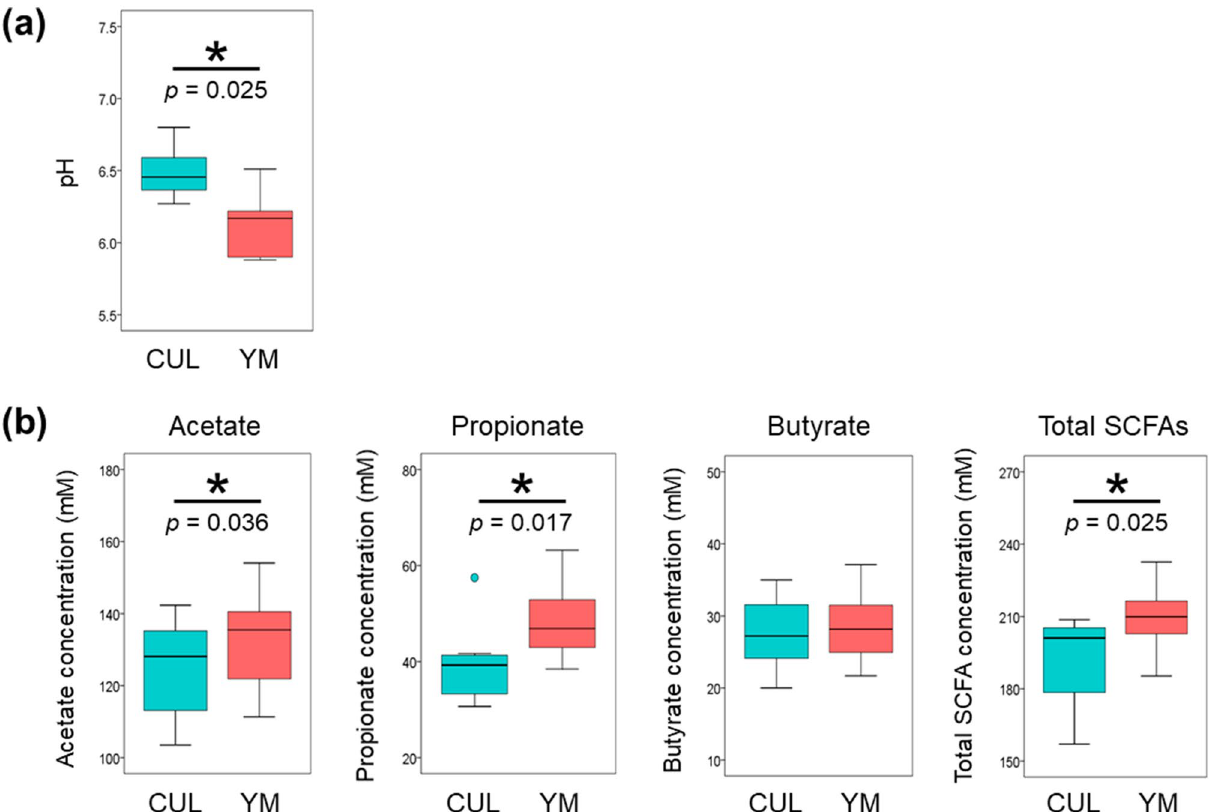
Figure 5. Changes in pH ( a ) and production of short-chain fatty acids (SCFAs) ( b ): acetate, propionate, butyrate, and total SCFAs after 30 h of fermentation in the KUHIMM without yeast mannan (CUL) and with the 0.4% yeast mannan preparation (YM). Asterisks (*) represent significant differences (* p < 0.05) (n = 8) using the Wilcoxon signed-rank